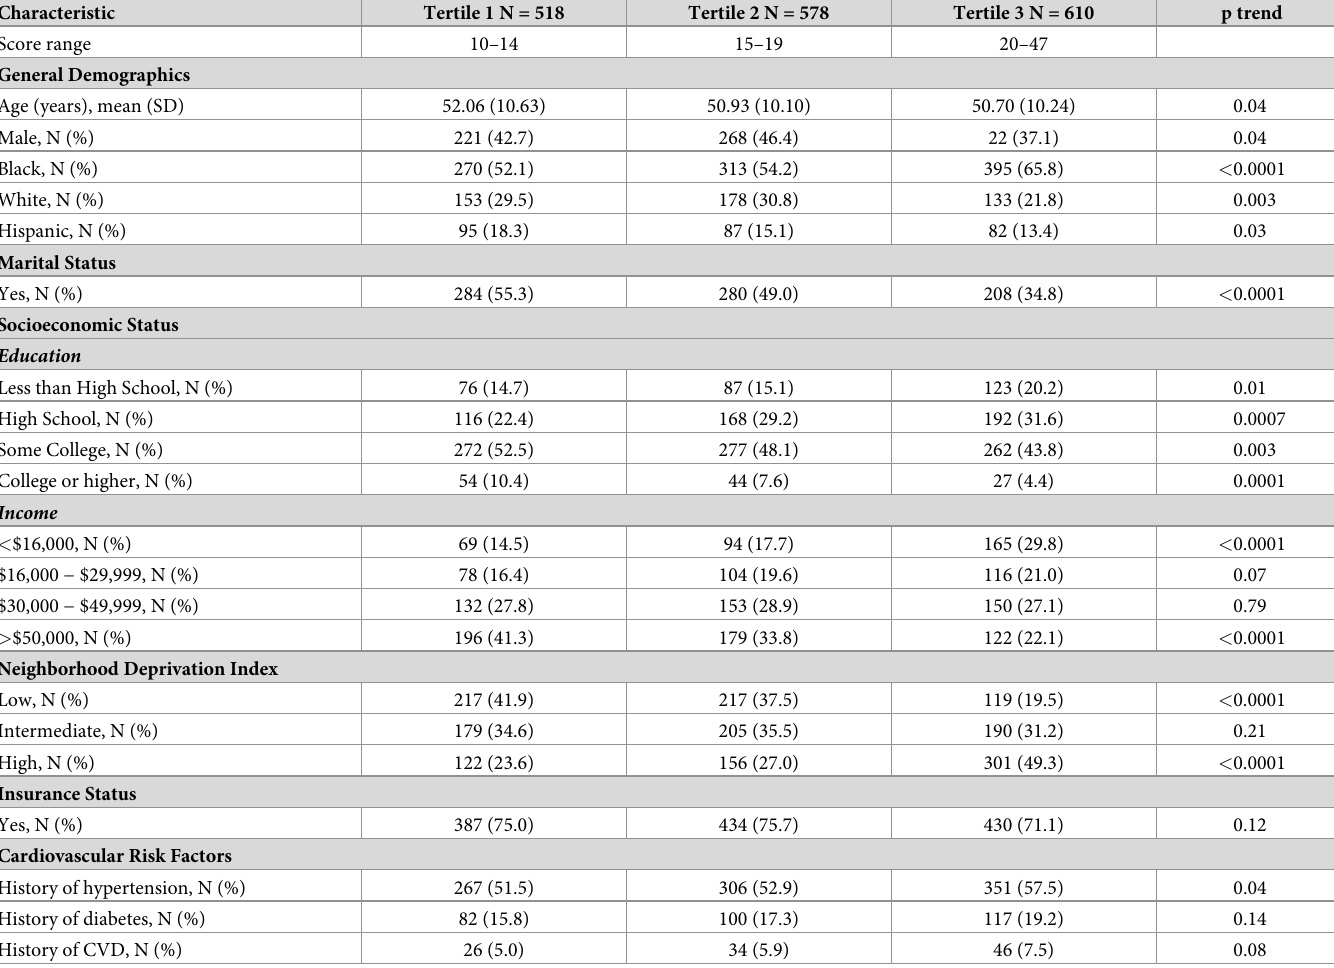
Table 1. Demographics, socioeconomic status, neighborhood deprivation index, insurance status, marital status, and cardiovascular risk factors across tertiles of total neighborhood environment perception (NEP) score for participants in the Dallas Heart Study (N = 1706) (2007–2009). Tertile 3 with most unfavorable NEP.